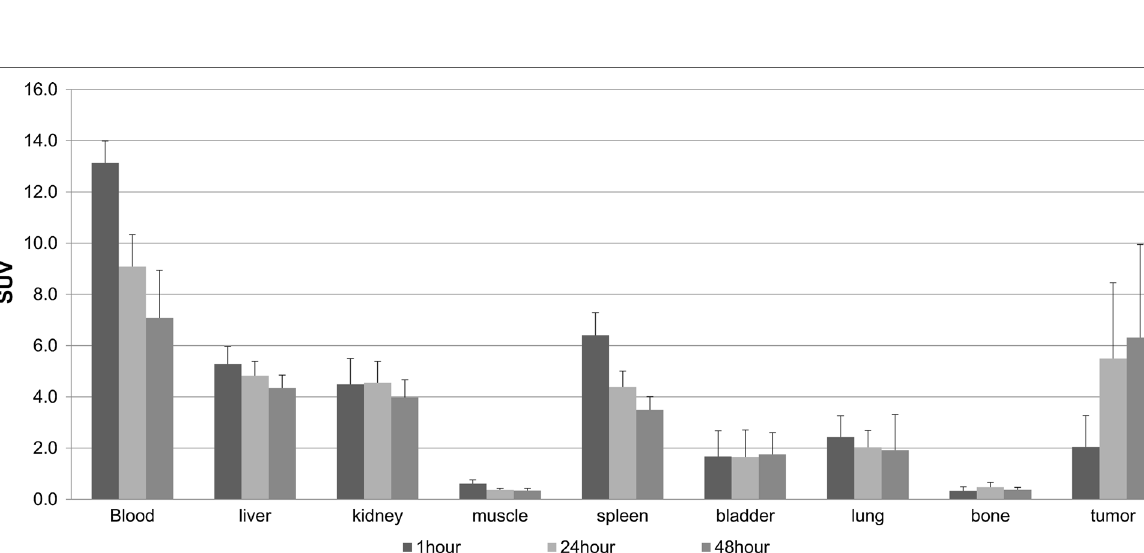
Fig. 2 Mean standardized uptake value (SUV mean ) with a standard error of 64 Cu‑NOTA‑Trastuzumab in normal organs and maximum standardized uptake value (SUV max ) with a standard error of 64 Cu‑NOTA‑Trastuzumab in